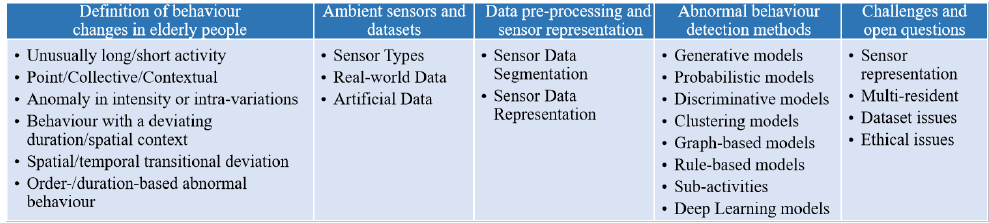
Figure 1. Overview of the